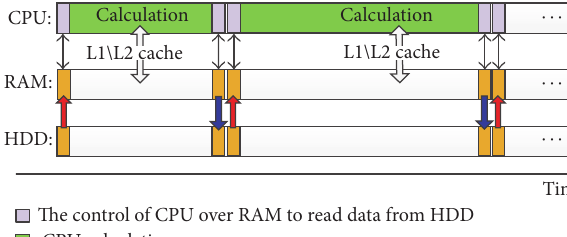
Figure 5: Operation sequence of the out-of-core scheme between RAM and HDD.